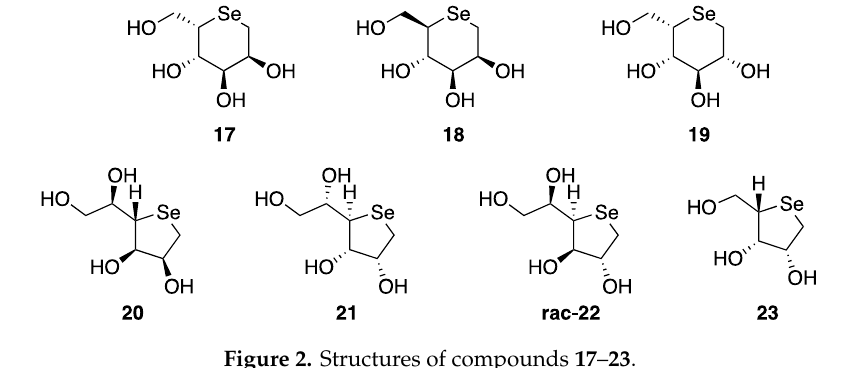
Figure 2. Structures of compounds 17 – 23 .